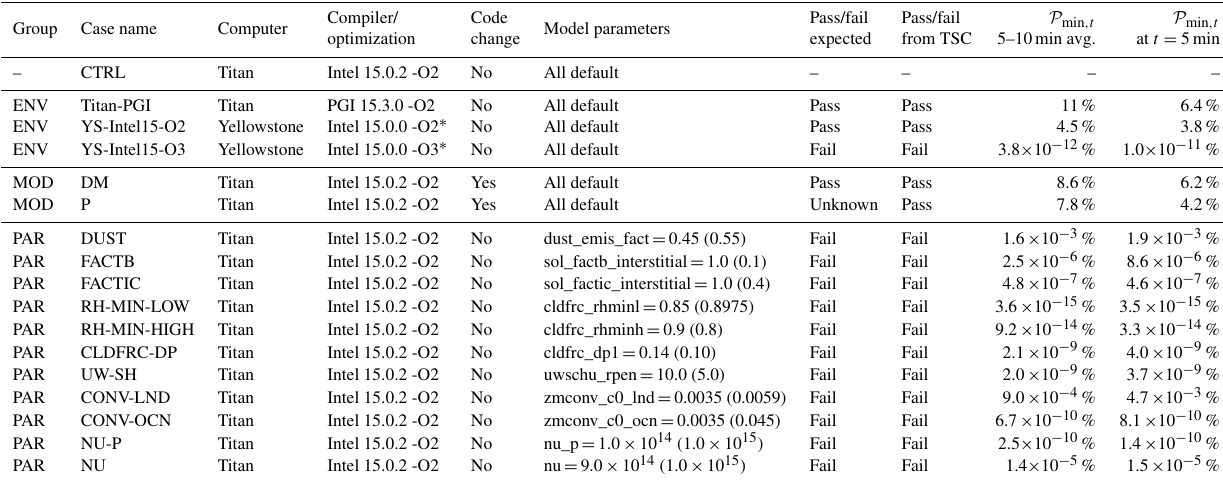
Table 1. CAM5 simulations conducted to evaluate the effectiveness of the TSC method. Simulations in group ENV used the same code but different computers, compiler versions, or optimization levels. Group MOD includes code modifications following Milroy et al. (2016). Group PAR includes parameter perturbation simulations following Baker et al. (2015). The pass/fail criterion and the definition of P min ,t can be found in Sect. 3.2.